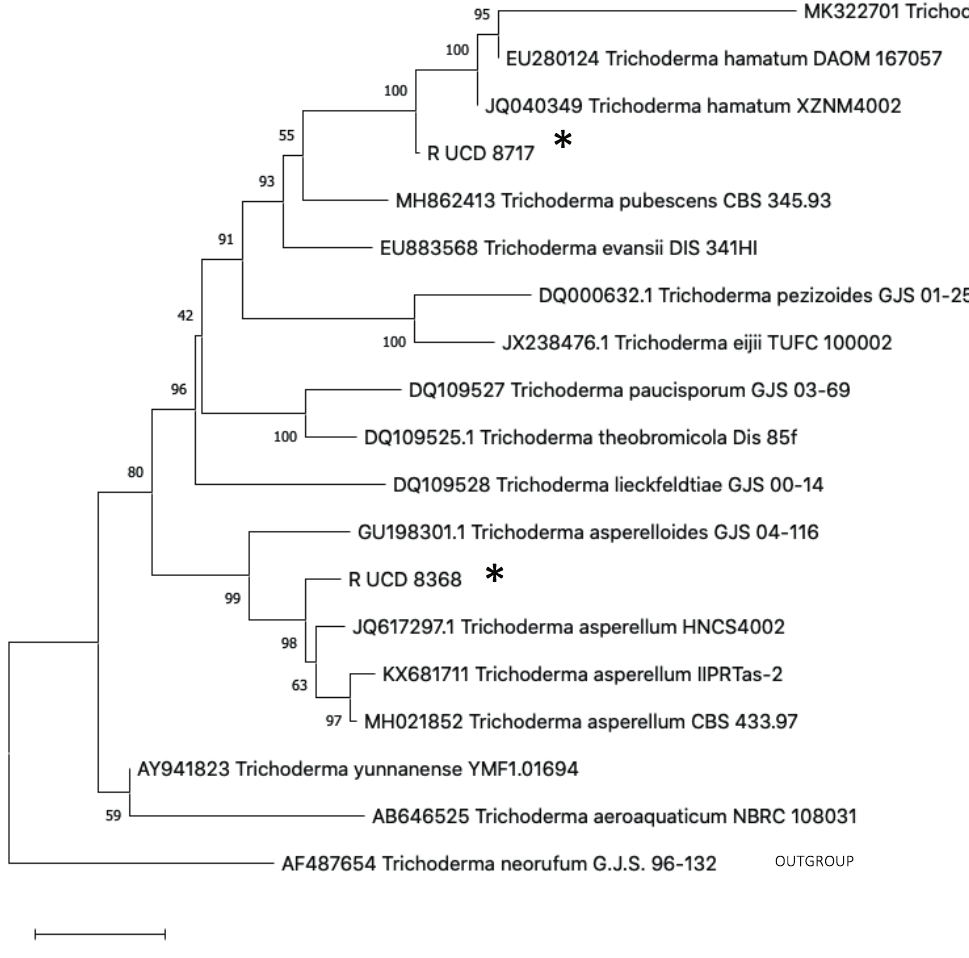
Figure 8. Maximum parsimony phylogenetic tree for isolates UCD 8368 and UCD 8717 based on a multigene alignment of the Trichoderma Hamatum/Asperellum clade using internal transcribed spacer rDNA (ITS), and translation elongation factor 1-alpha (TEF1). Bootstrap sup- port for the maximum-likelihood analysis is given at each node (1000 replicates). * indicates subcultures evaluated in this study. Tricho- derma neorufum AF487654 was used as an